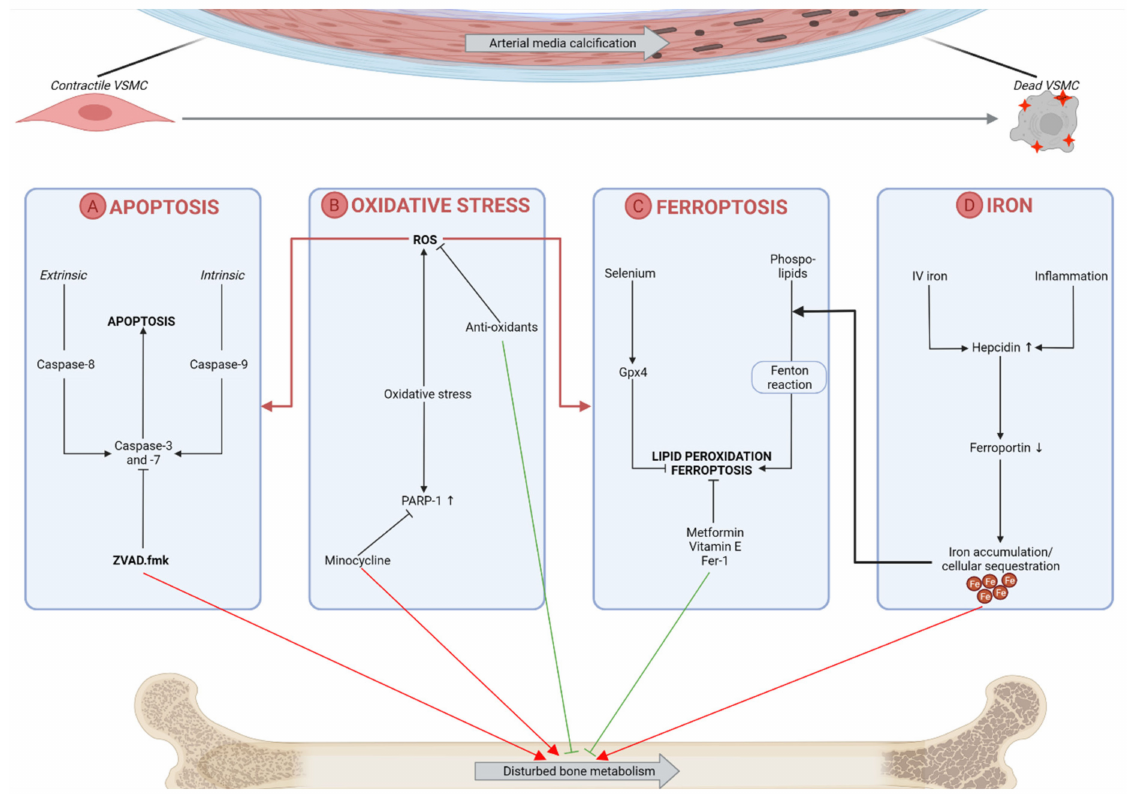
Figure 1. Targeting vascular smooth muscle cell (VSMC) death and oxidative stress-related pro- cesses as a possible way to tackle arterial media calcification and its effect on bone mineralization. ( A ) Apoptosis, a caspase-dependent type of cell death, contributes to the development of arterial media calcification. Apoptotic bodies act as a nucleation site for the deposition of